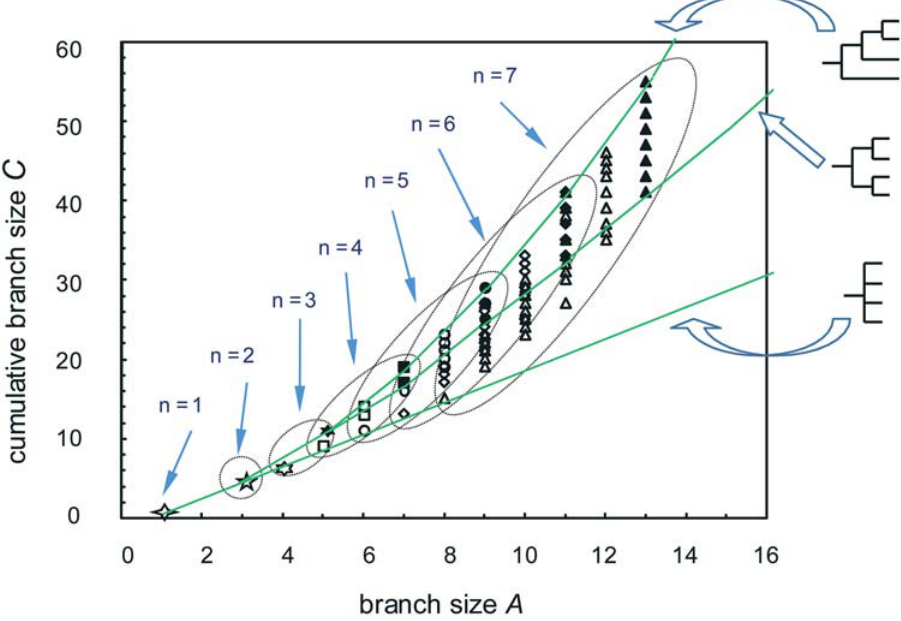
Figure 1. Distribution of rooted, unlabeled trees in tree-shape space, defined by branch size ( A ) and cumulative branch size ( C ). All trees of up to 7 terminal taxa are shown. Solid symbols indicate binary trees, empty symbols stand for non-binary trees. Ellipses encompass all trees with the same number of terminal taxa (n). The lines are the interpolated expectation for three kinds of trees (the 4-taxa examples shown at right): totally symmetrical, random average (middle); pectinate, most imbalanced (top); and totally unresolved, trivial (bottom). The space actually occupied by all trees is limited by the upper and lower bounds. All binary (fully resolved) trees occur at or above the limit imposed by symmetrical trees. Only trees including at least one polytomy (non-binary, or unresolved) occur below this limit.